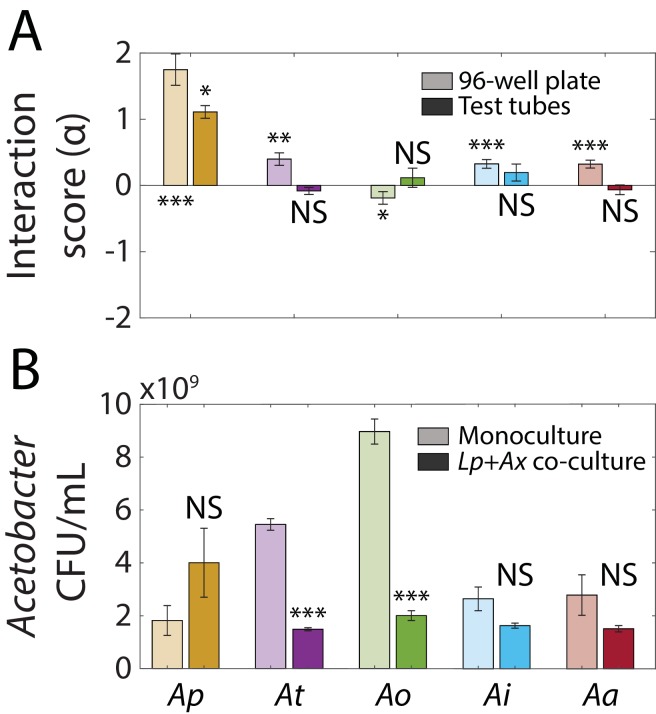
Interaction scores of Lactobacillus plantarum (Lp) and Acetobacter spp.(A) Interaction score for Lp and Acetobacter spp. calculated using OD (Equation 1) measured after 48 h of growth in a 96-well plate (light colors) or in test tubes (dark colors). Error bars indicate standard deviation (S.D.), n = 5 for 96-well plates, n = 3 for test tubes. P-values are from a Student’s two-sided t-test of the hypothesis that the score is 0 using the mean OD of individual samples (monocultures and co-cultures) to calculate the mean and S.D. by propagation of error (*: p<5×10−3, **: p<1×103, ***: p<1×10−4, equivalent to *: p<0.05/n, **: p<0.01/n, ***: p<1×10−3/n, where n = 10 is the number of comparisons). (B) Co-culturing with Lp did not significantly increase Ap cell density, but did significantly decrease At and Ao cell densities after 48 hr. Error bars are S.D. for each condition, n = 3. p-values are from a Student’s two-sided t-test of the difference from the monoculture (***: p<2×10−4, equivalent to ***: p<1×10−3/n, where n = 5 is the number of comparisons).